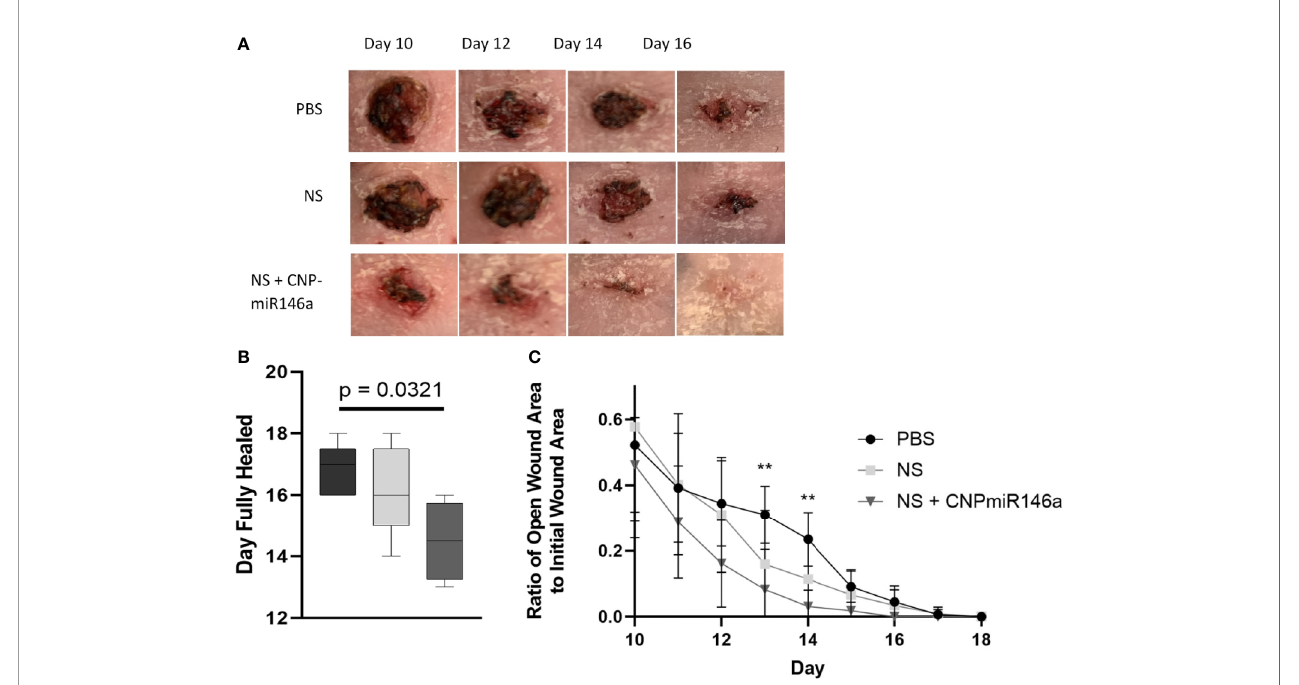
FIGURE 2 | (A) Representative images of diabetic murine wounds during the healing process after PBS, NS, or NS + CNP-miR146a topical treatments. (B) Diabetic wounds closed signi fi cantly faster when treated with NS + CNP-miR146a. (C) Wounds were signi fi cantly smaller 13 and 14 days after wounding following treatment with CNP-miR146a compared to PBS-treated controls 14 days after treatment (**p <